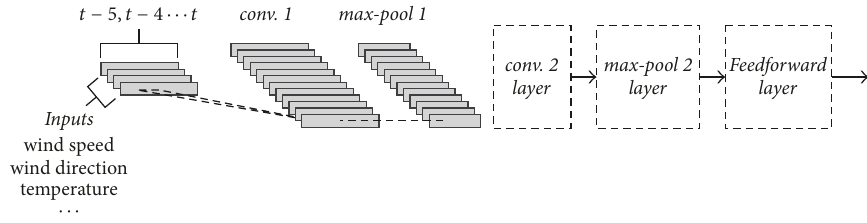
Figure 2: General diagram of the CNNs used.